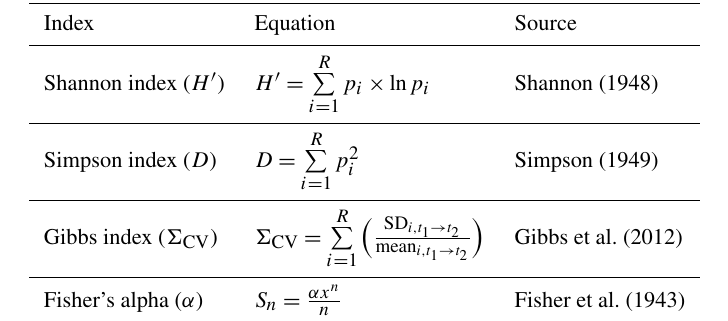
Table 4. Diversity and variability indices for (fossil) assemblages. In the Shannon and Simpson indices, p i represents the proportional abundance of the i th taxon of the total amount of taxa R . The Gibbs index summates the coefficients of variation (SD / mean) of all taxa ( i to R) over a certain rolling window t 1 → t 2 . In Fisher’s alpha, the α parameter is estimated from the dataset in which S is the expected number of species with an abundance of n . x represents a nuisance parameter estimated from the dataset, generally between 0.9 and 1. While the Gibbs index is calculated over a rolling window, the other indices are calculated per